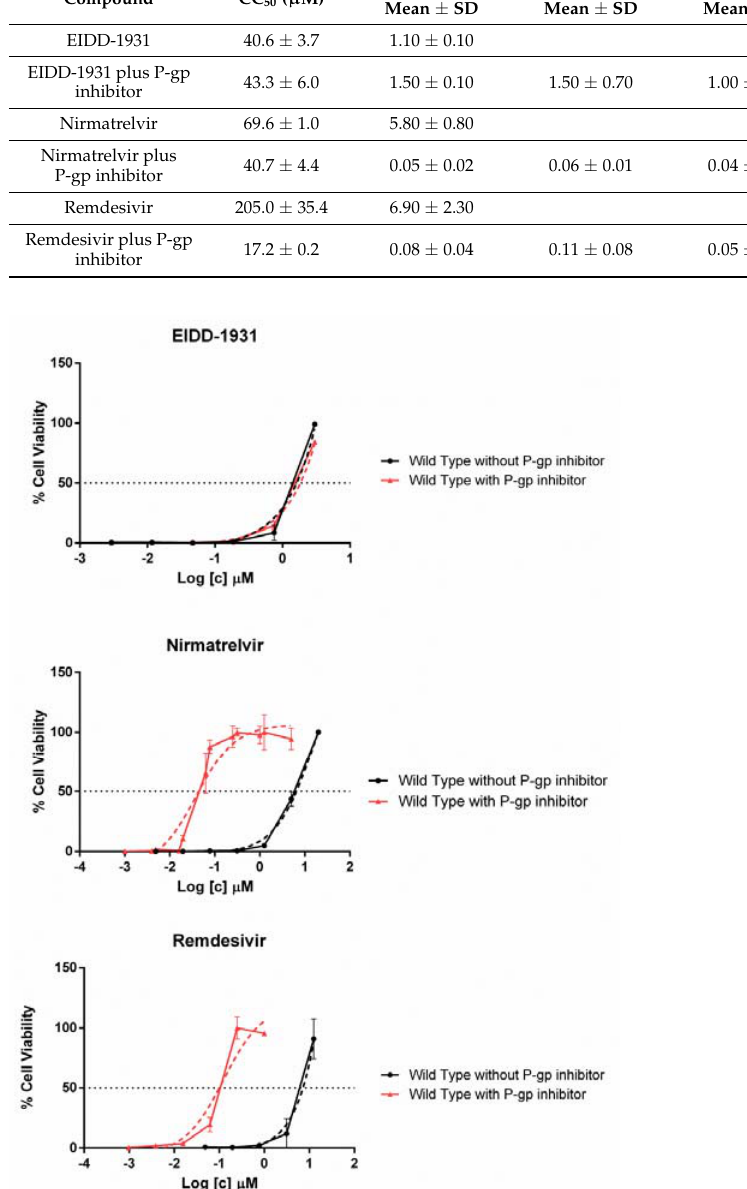
Figure 2. Comparison between antiviral activity of EIDD-1931, Nirmatrelvir and Remdesivir against wild-type SARS-CoV-2 virus with (0.5 µ M) or without the addition of P-gp inhibitor. On the x-axis is indicated the micromolar drug concentration in logarithmic scale. The horizontal dashed line indicates the drug IC 50 corresponding to 50% cell viability whereas the dashed curves indicate the dose response fitting curve generated by GraphPad PRISM software version 6.01 (La Jolla, CA,